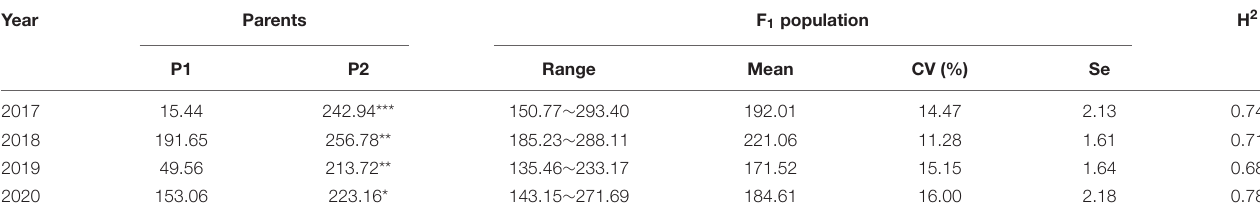
TABLE 1 | Statistical analysis of LS means of photothermal units values in parents and F1 population across 4 years.